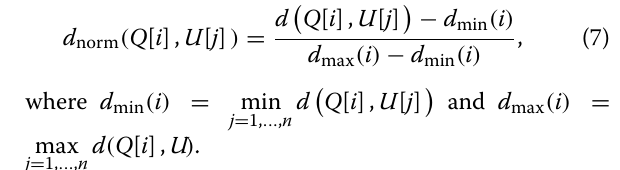
probability is the highest are considered to be silence and discarded.